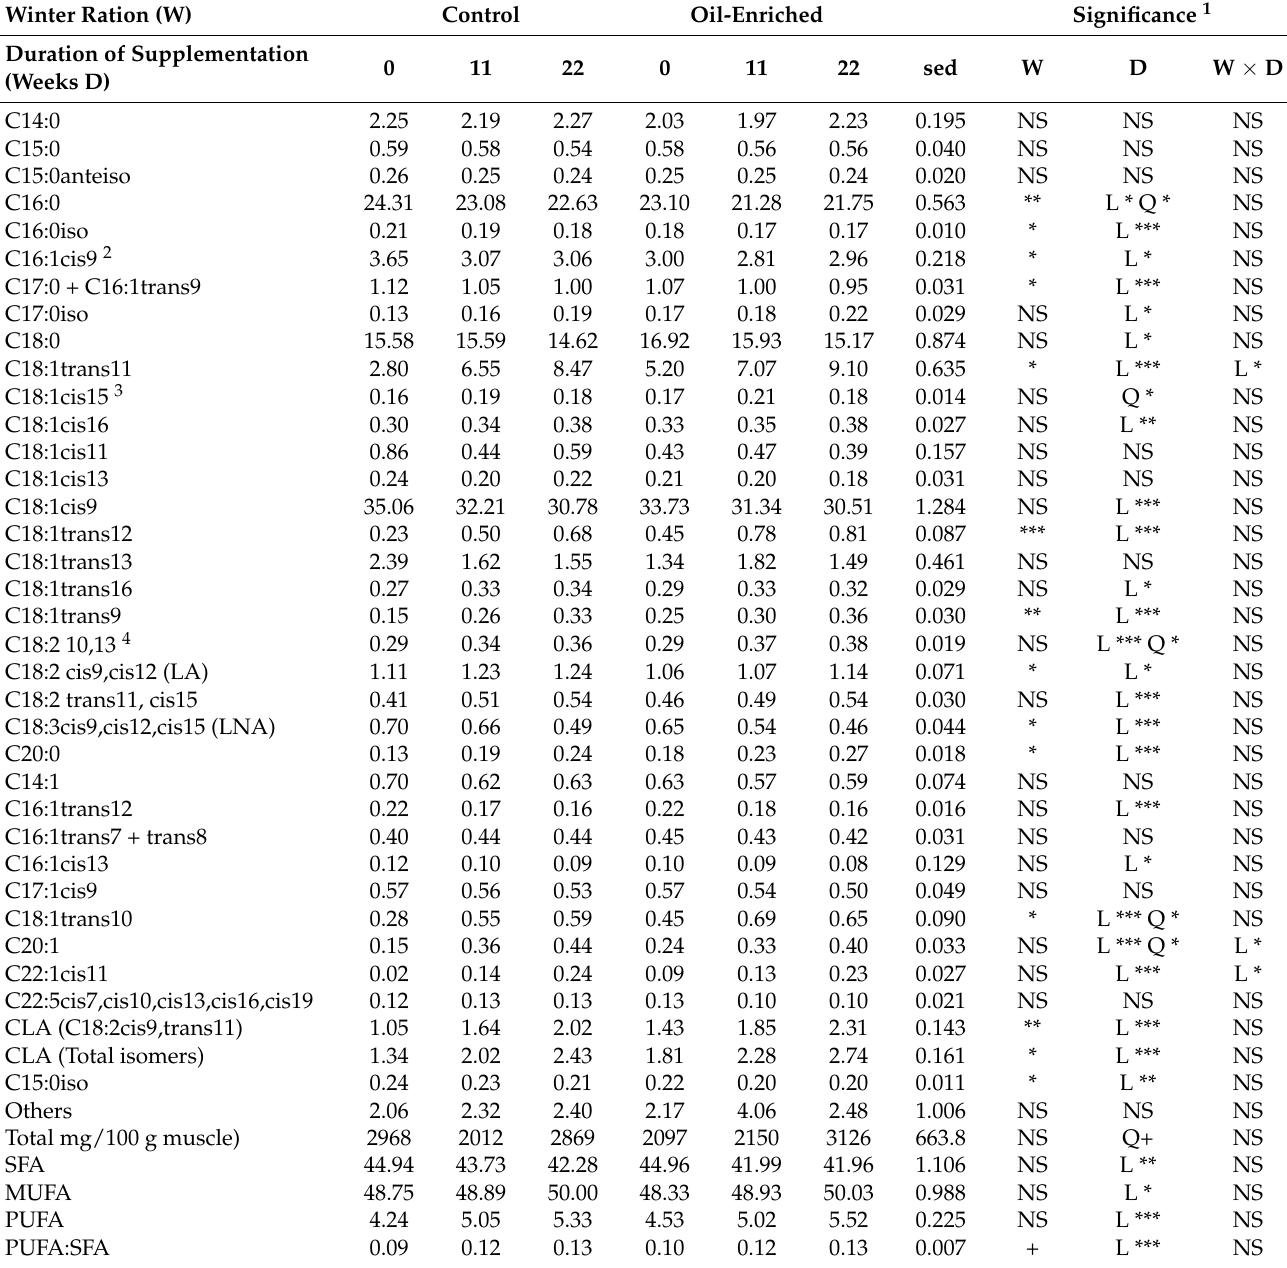
Table 8. Proportions of fatty acids in the neutral lipid fraction of longissimus muscle of beef